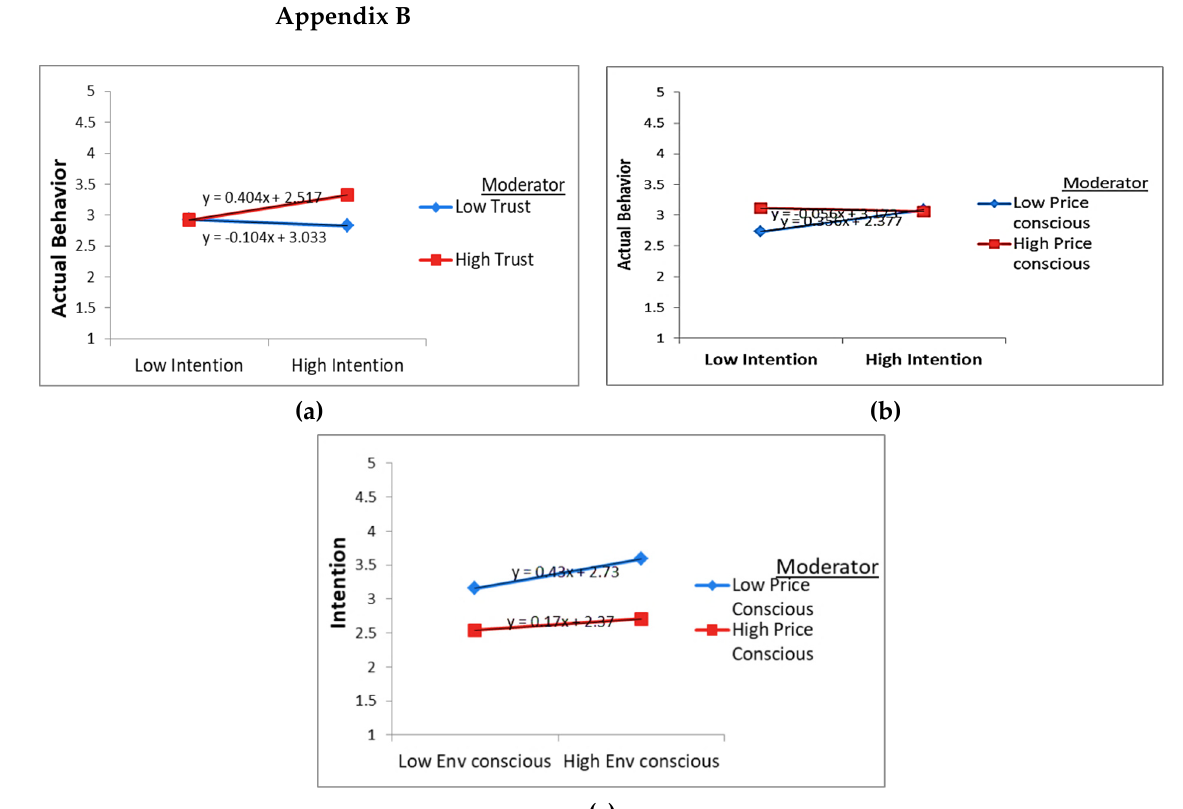
Figure A1. ( a , b ) Trust and price consciousness moderates intention-behavior ( c ) price consciousness do not moderate EC and PI relationships.